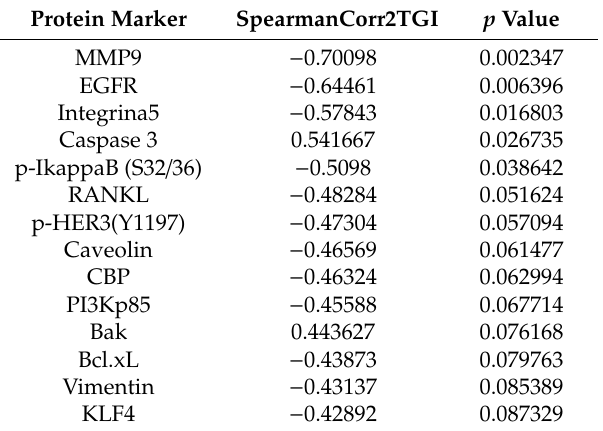
Table 2. Baseline protein markers of response to BKM120.